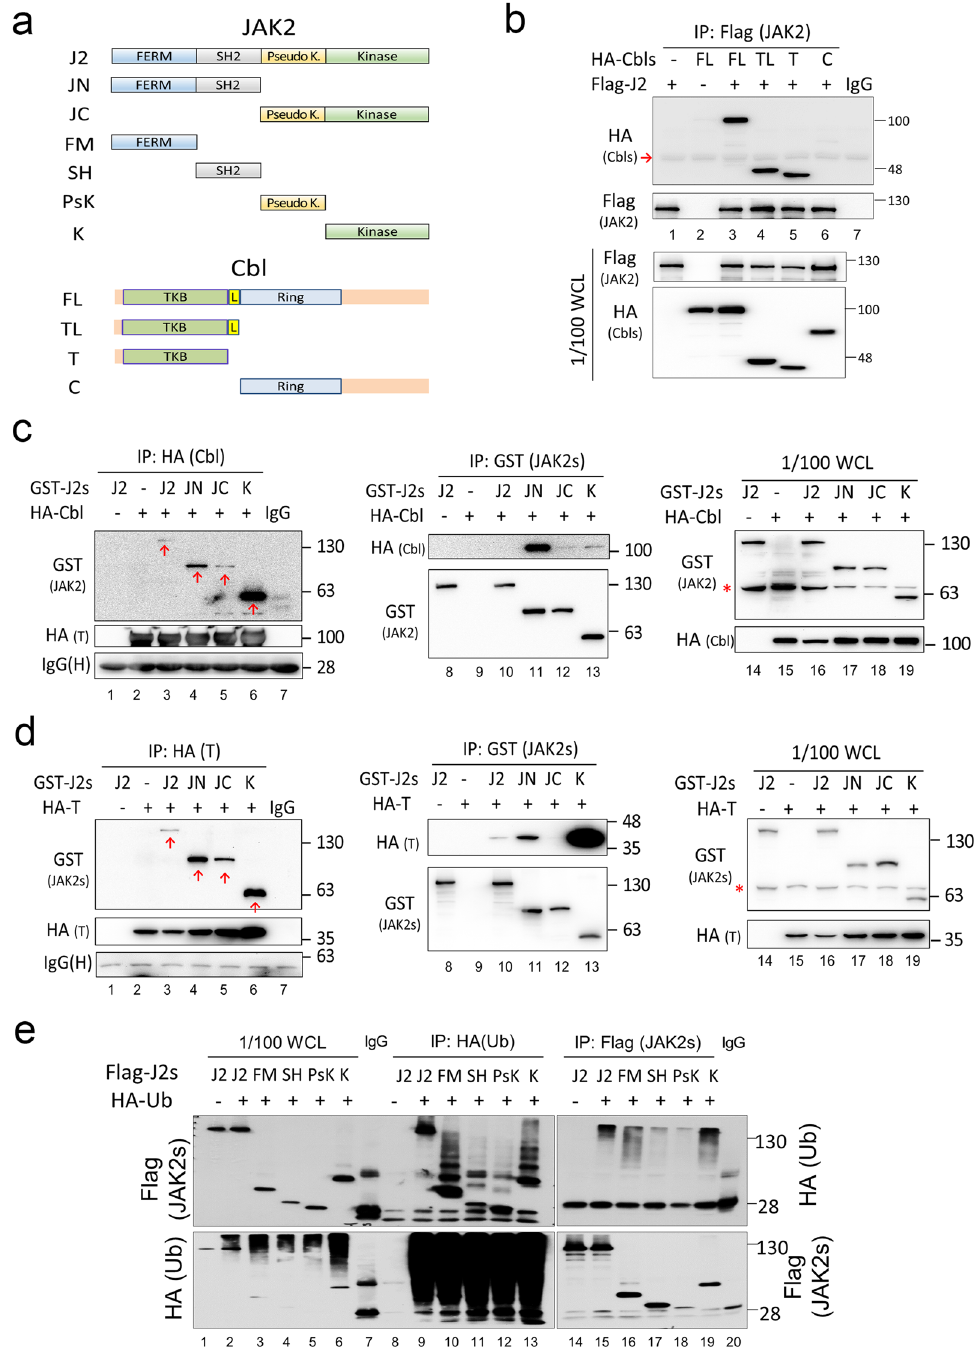
Figure 5. FERM and kinase domains of JAK2 are preferentially bound and ubiquitinated by Cbl. ( a ) Schematic representations of the full-length and sub-domains of JAK2 and Cbl that were used in the following experiments. ( b ) Interaction between full-length JAK2 and Cbl domains. 293 T cells were co-transfected with full-length (FL) Flag-tagged JAK2 and the various HA-tagged Cbl domains. WCL were IPed with an anti-Flag affinity gel, and the IPs as well as the WCL (input control) were analysed by Western blotting with the indicated antibodies. Red arrow indicates the IgG heavy chain from IP. ( c , d ) Interaction between Cbl and domains of JAK2. 293 T cells were co-transfected with the indicated GST-tagged domains of JAK2 and/or HA-tagged full length Cbl (FL) (panel c) or the TKB domain of Cbl (T) (panel d). Cells were then analysed as described above. The right hand column displays Western blots of the respective WCLs (input control). Red arrow indicates the different JAK2 fragments. Red asterisk marks a non-specific band. ( e ) Ubiquitination of JAK2 domains. 293 T cells were co-transfected with HA-tagged ubiquitin and various Flag-tagged JAK2 domains shown in ( a ). WCL were IPed and analysed as described above. IgG(H): IgG heavy chain. WCL: whole cell